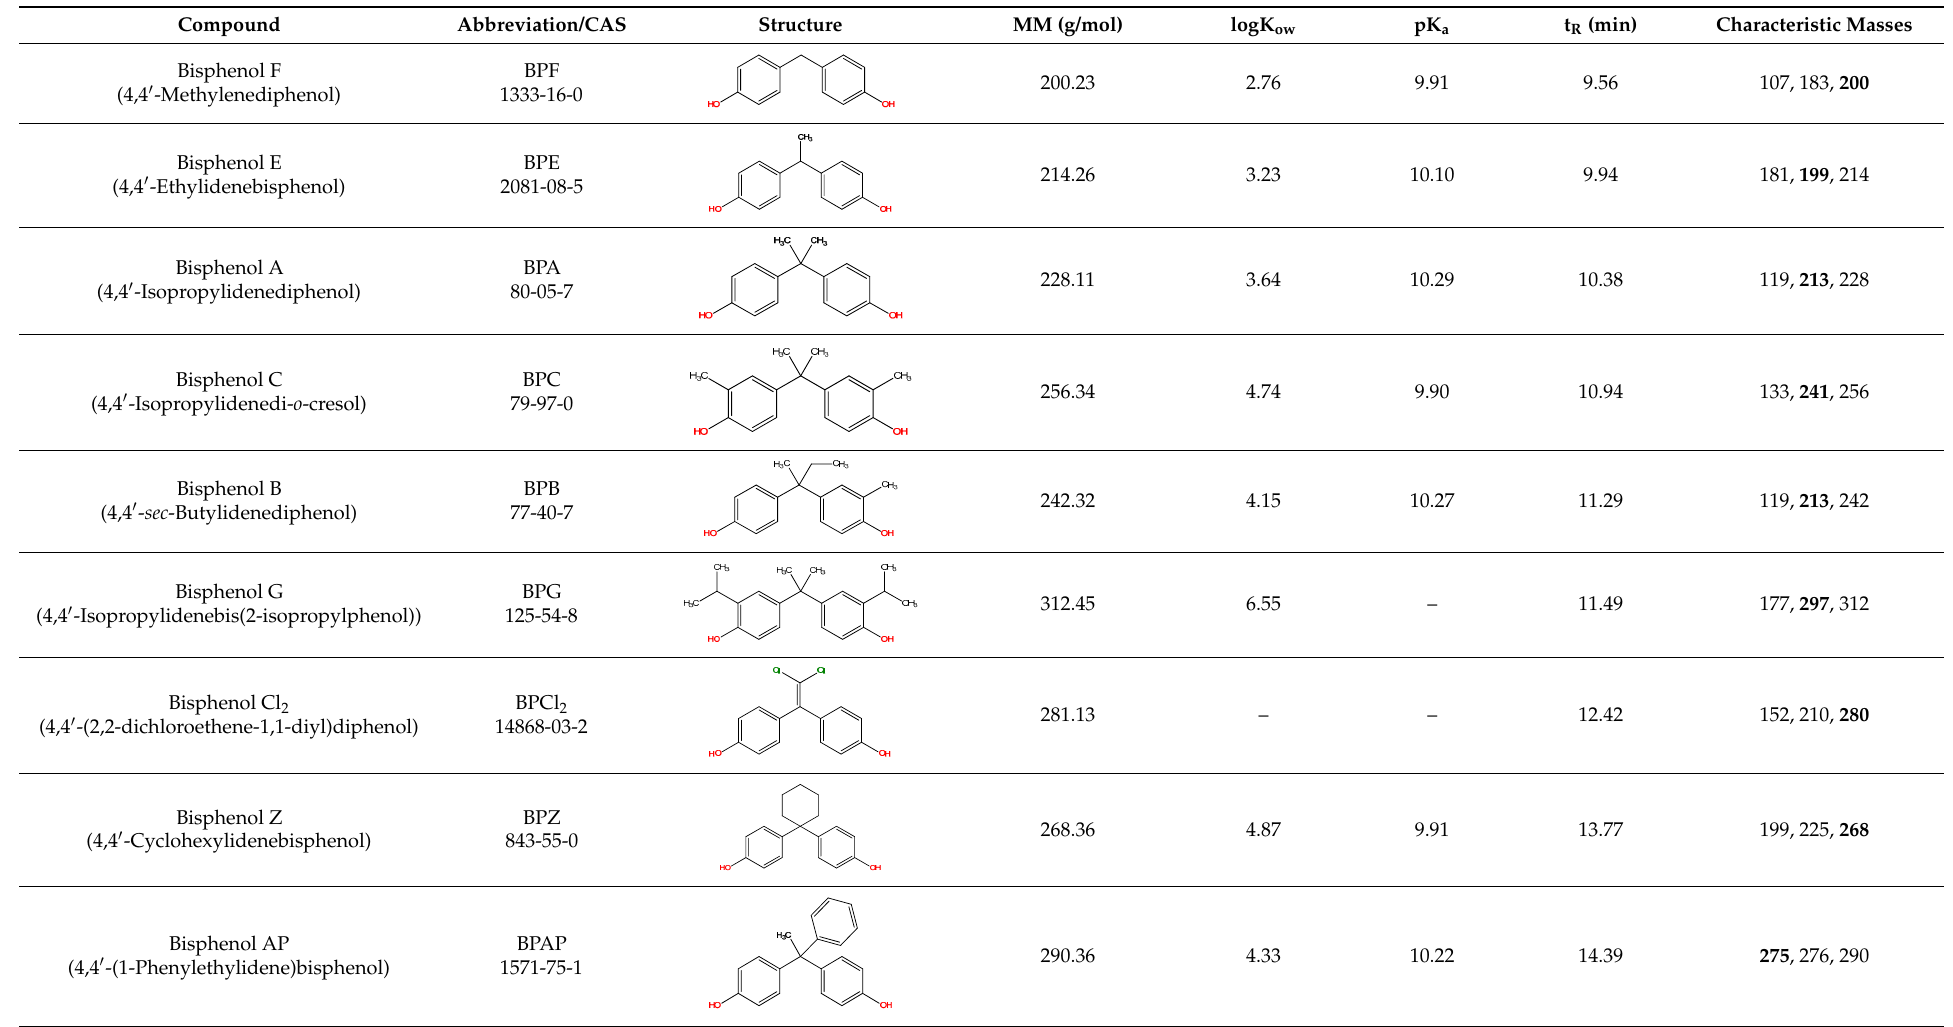
Table 1. Basic information about determined bisphenols.